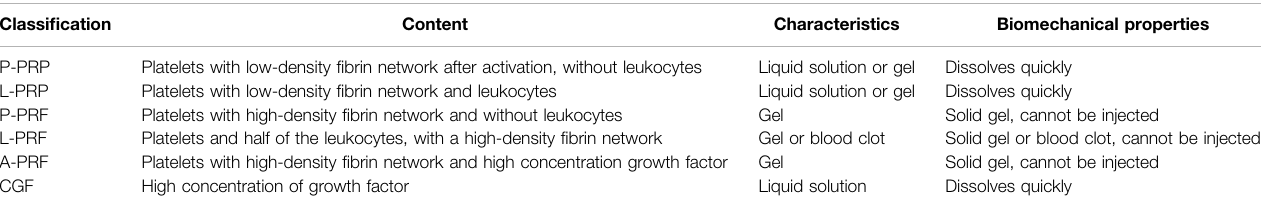
TABLE 3 | Summary of classi fi cations of PRP (Huang et al.,